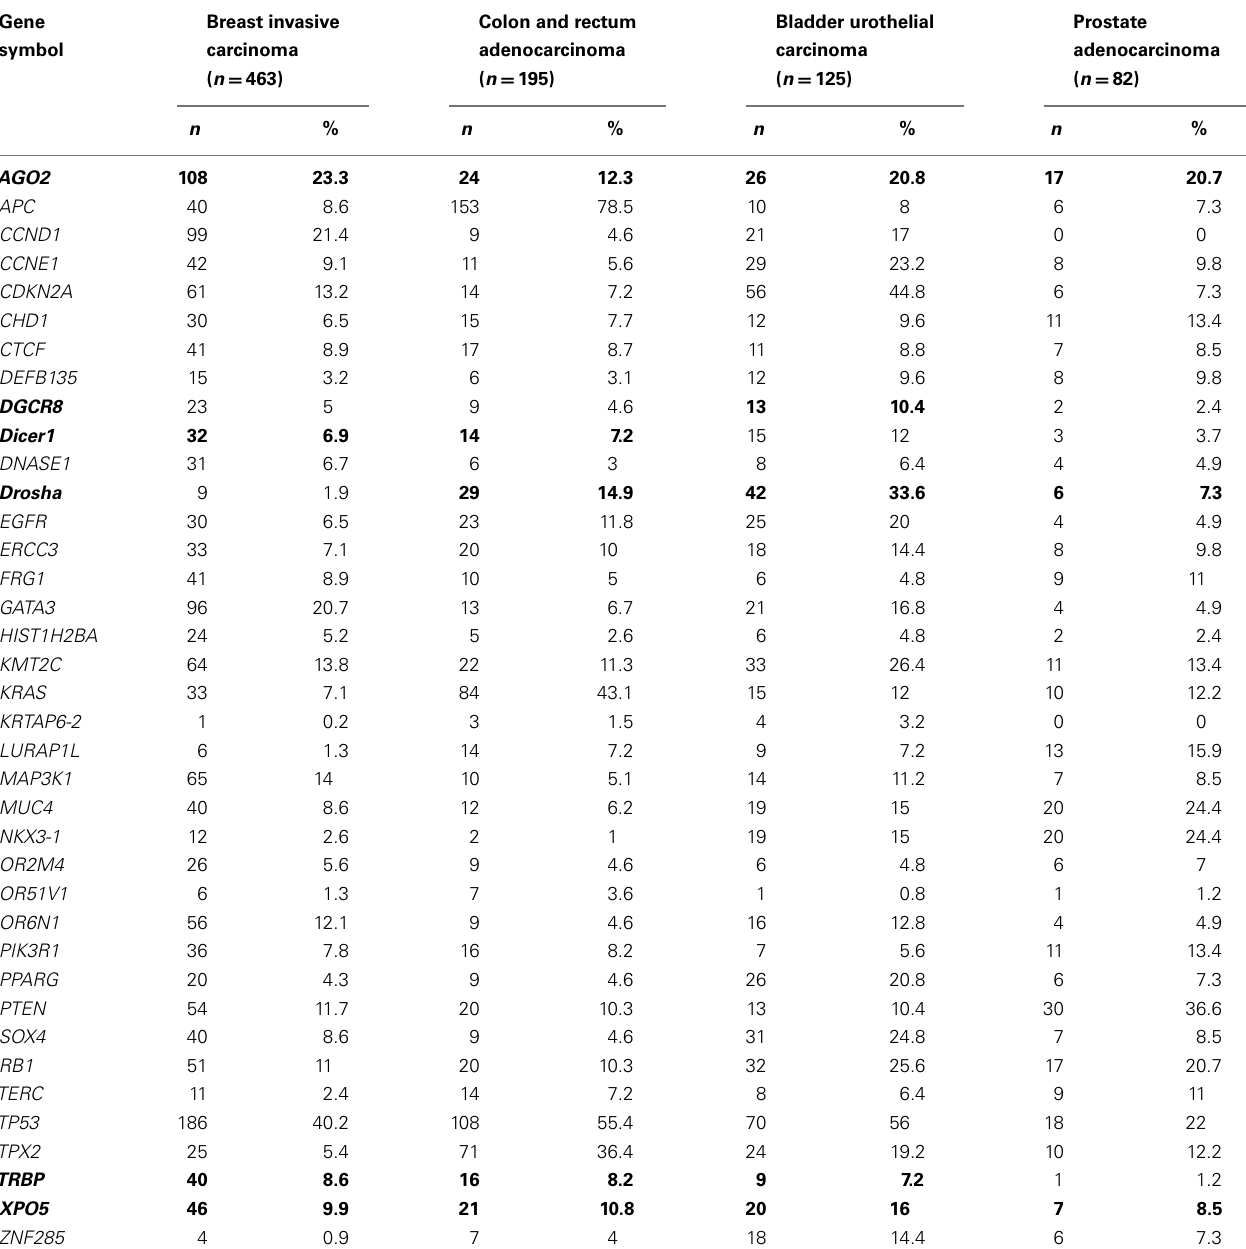
Table 1 |The Cancer GenomeAtlas consortium data on the incidence of genetic alterations a in microRNA machinery genes b and driver genes c , by cancer type